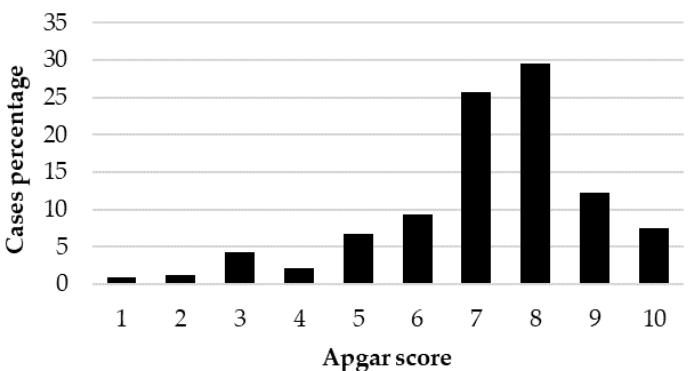
Figure 2. Distribution of the Apgar score (case percentage) in the 412 small-sized live-born puppies.